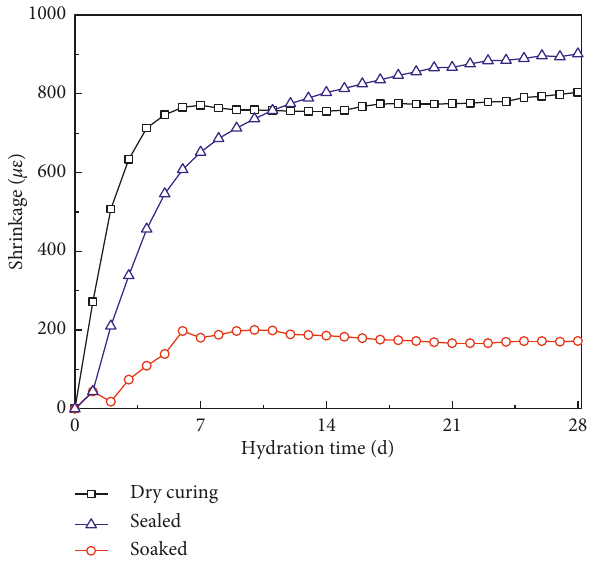
Figure 1: 28 d shrinkage of hardened slurry in different curing